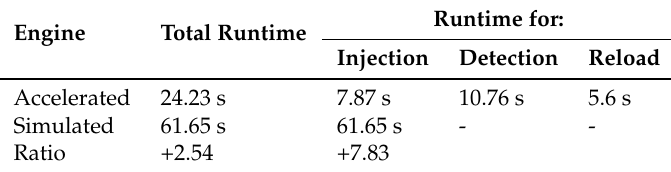
Table 6. Run time average of each acceleration step for the TT case.